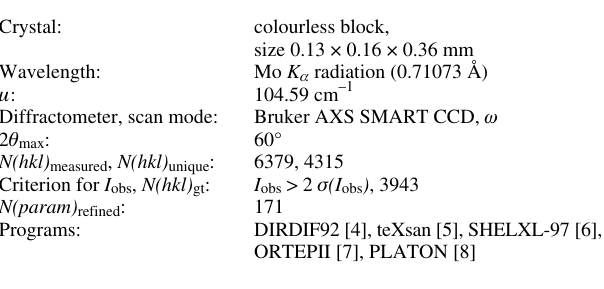
Table 1. Data collection and handling.